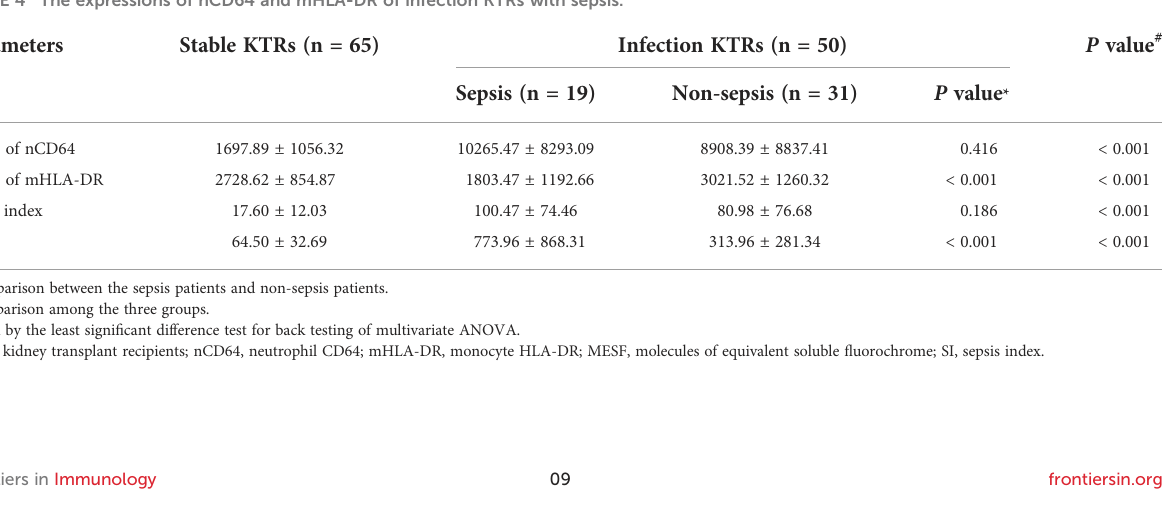
TABLE 4 The expressions of nCD64 and mHLA-DR of infection KTRs with sepsis. Parameters